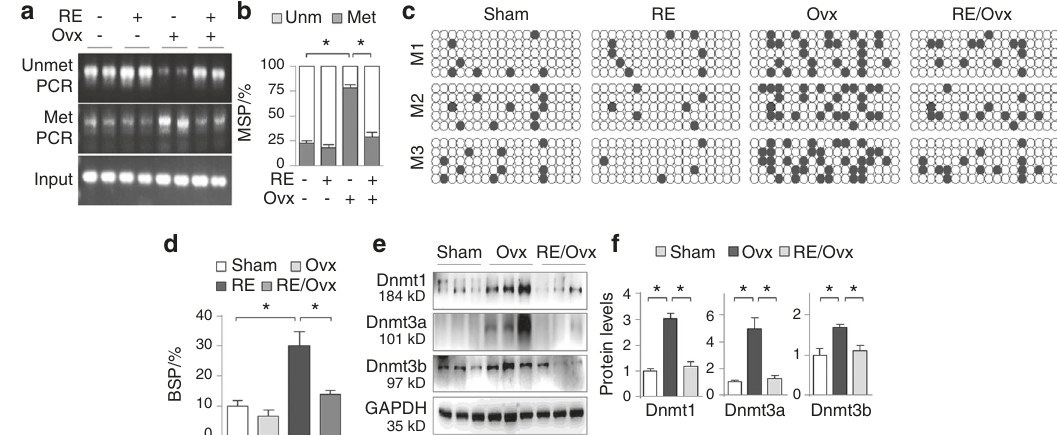
Fig. 3 Running exercise demethylates the Nrf2 promoter and inhibits aberrant femoral Dnmt expression. Female ICR mice were treated and divided into the sham, Ovx, RE, and RE/Ovx groups (6 mice in each group) as described in the methods. a MSP assay. Representative agarose gel analysis of MSP products. Two samples from each group are shown. b Quanti fi cations of MSP products in Fig. 3a. Values are presented as percentage changes of methylated/unmethylated PCR over total PCR products after adjustment with input controls, * P < 0.05, two-way ANOVA. c BSP assay. Three randomly selected mice (M1, M2, and M3) from each group were analyzed by BSP (the primer positions on the Nrf2 promoter are shown in Fig. 2a, right panel). The PCR products were cloned, and fi ve clones from each PCR were sequenced. One box represents one mouse. Each row of dots in the box represents one single sequenced clone, and each dot represents one CpG site. Empty or dark dots indicate unmethylated or methylated CpGs, respectively. d Quanti fi cation of Fig. 3c. Data are presented as the mean percentage ± SEM of methylated CpGs over total CpGs in each group. * P < 0.05, two-way ANOVA. e Western blotting of mouse femoral Dnmt1, Dnmt3a and Dnmt3b. Three randomly selected samples from each group are shown. f Quanti fi cations of Fig. 3e. * P < 0.05, one-way ANOVA Bone Research (2021)